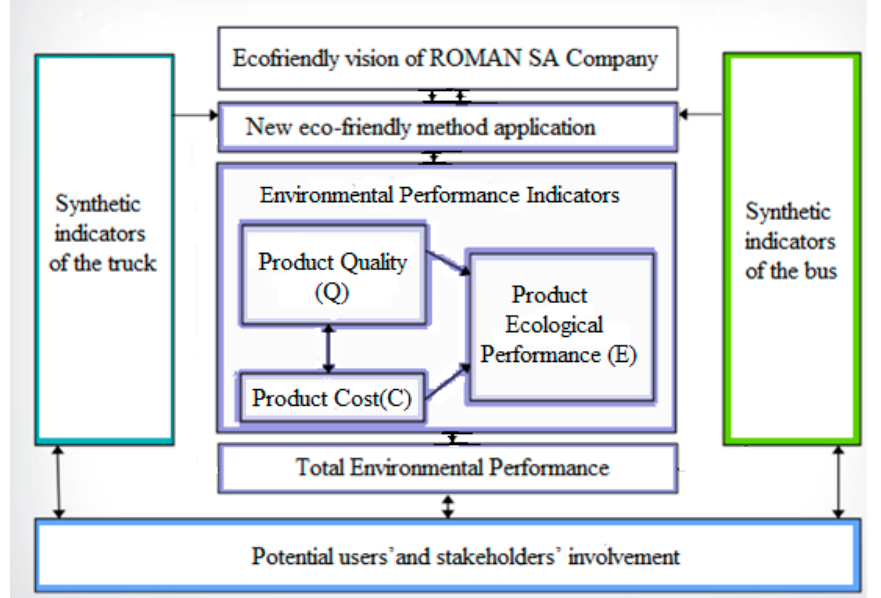
Figure 3. Graphical representation of the application of the new eco-friendly method at the Roman SA Company. SA